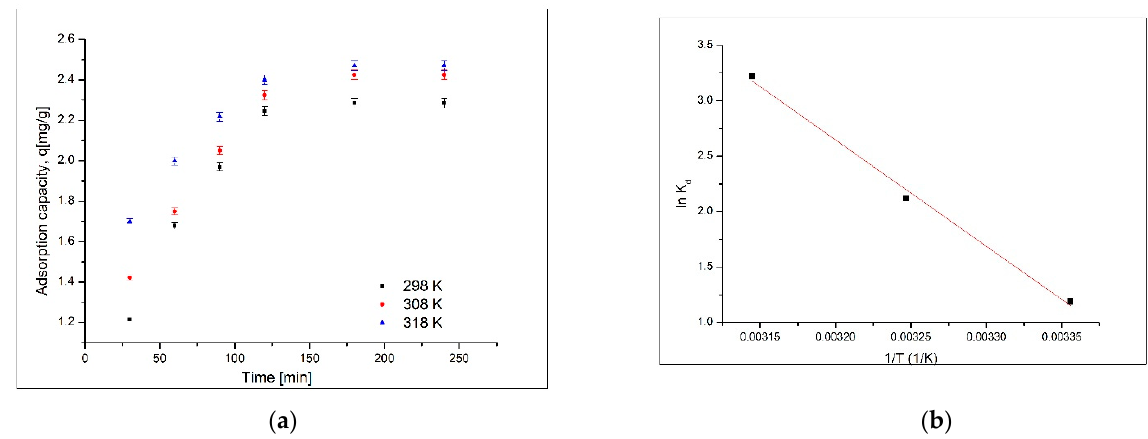
Figure 8. Thermodynamic studies. ( a ) Influence of contact time and temperature; ( b ) Linear dependence ln k d versus 1/T